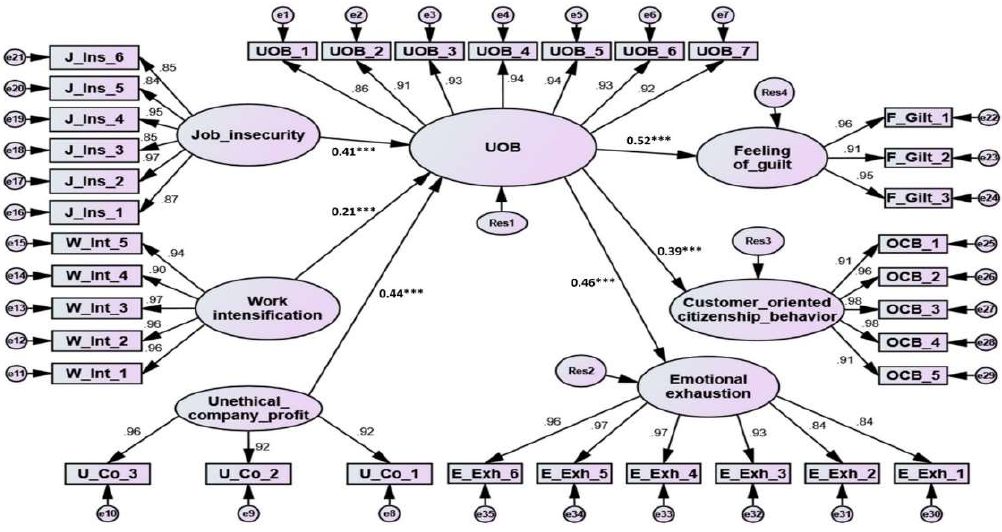
Figure 2. Structural and measurement model. ***: significant level less than 0.001.